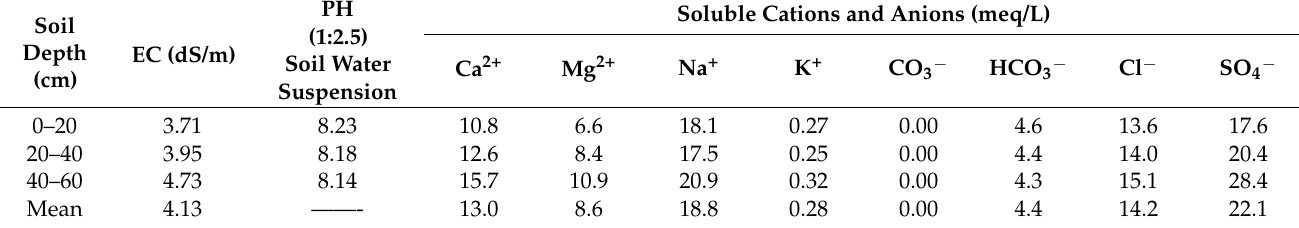
Table 2. Chemical properties of the experimental soil.